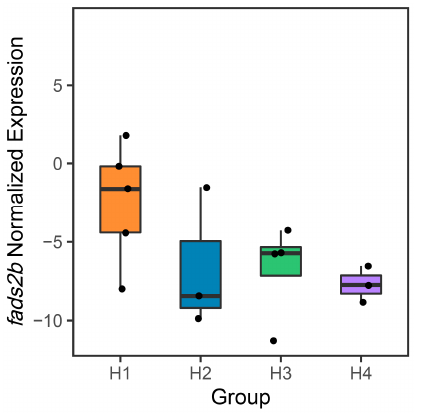
Figure 2. Whisker plots of the fads2b gene expression levels among different genotype combinations of four fads2b pSNPs (F2b.-104, F2b.-304, F2b.-700, and F2b.-785). H1: AT/CC/GG/AT. H2: AA/CT/GG/TT. H3: TT/CC/GG/AA. H4: TT/CC/GG/TT.